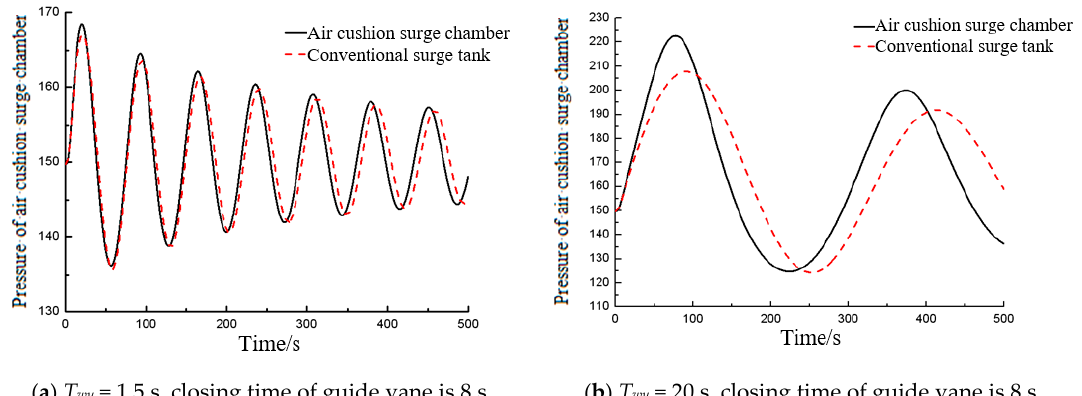
Figure 3. Effects of the air cushion surge chamber and conventional surge tank on pressure under large fluctuations [55].